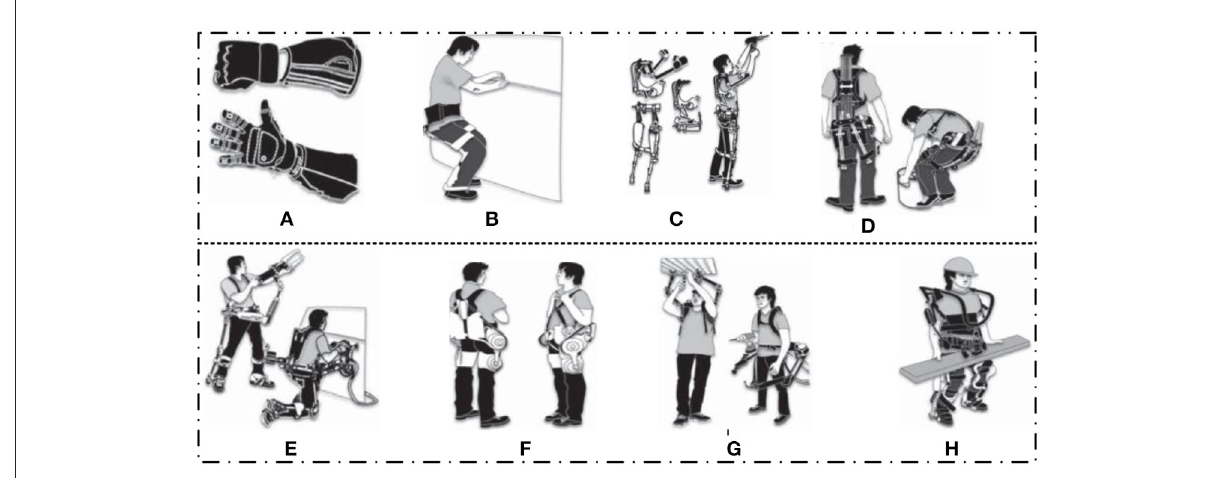
FIGURE3 Exoskeletons with multiple application purposes (Fox et al., 2019). (A) Exoskeleton gloves (Yun et al., 2017) can minimize the operator’s force to grasp a tool and provide assistance during the execution of a task (Yurkewich et al., 2019). (B) Chairless chairs, which are wearable chairs consisting of two supports for the backs of the legs that touch the ground when wearers bend their knees to sit. (C) Exoskeletons for the shoulders (Islam et al., 2020), back, and legs can be manufactured. This can decrease human musculoskeletal pressure from repetitive, light overhead work. (D) This exoskeleton structure can contribute to and yield supporting power through the use of carbon fiber rods, which act as artificial tendons by bending when the wearer squats and springing back when they stand up. (E) Exoskeletons can deliver direct help for heavy hand tools by offloading their weight onto external support, such as a floor, via a series of linkages at hips, knees, and ankles, bypassing the wearer’s body. (F) A powered exoskeleton’s ability to communicate or combine different materials, such as batteries, sensors, actuators, and motors, is crucial (Ismail et al., 2019). (G) Powered exoskeletons can expand the human body by supplying and influencing energy to the arms and legs. In (H) the exoskeleton platform can be designed in an improved manner and made strong to maximize the loads that can be supported (Cho et al.,